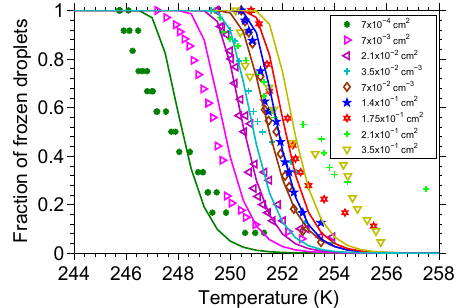
Figure 8. Experimental freezing curves for different mass concen- trations of illite NX powder immersed in 500–700µm diameter wa- ter droplets obtained using the CMU cold plate (circles). The solid lines are the predicted frozen fractions based on the g distribution retrieved from the Broadley et al. (2012) data and a surface area correction. A concentration saturation effect appears to be present, whereby the blue, red, and gold experimental data points overlap despite being at different